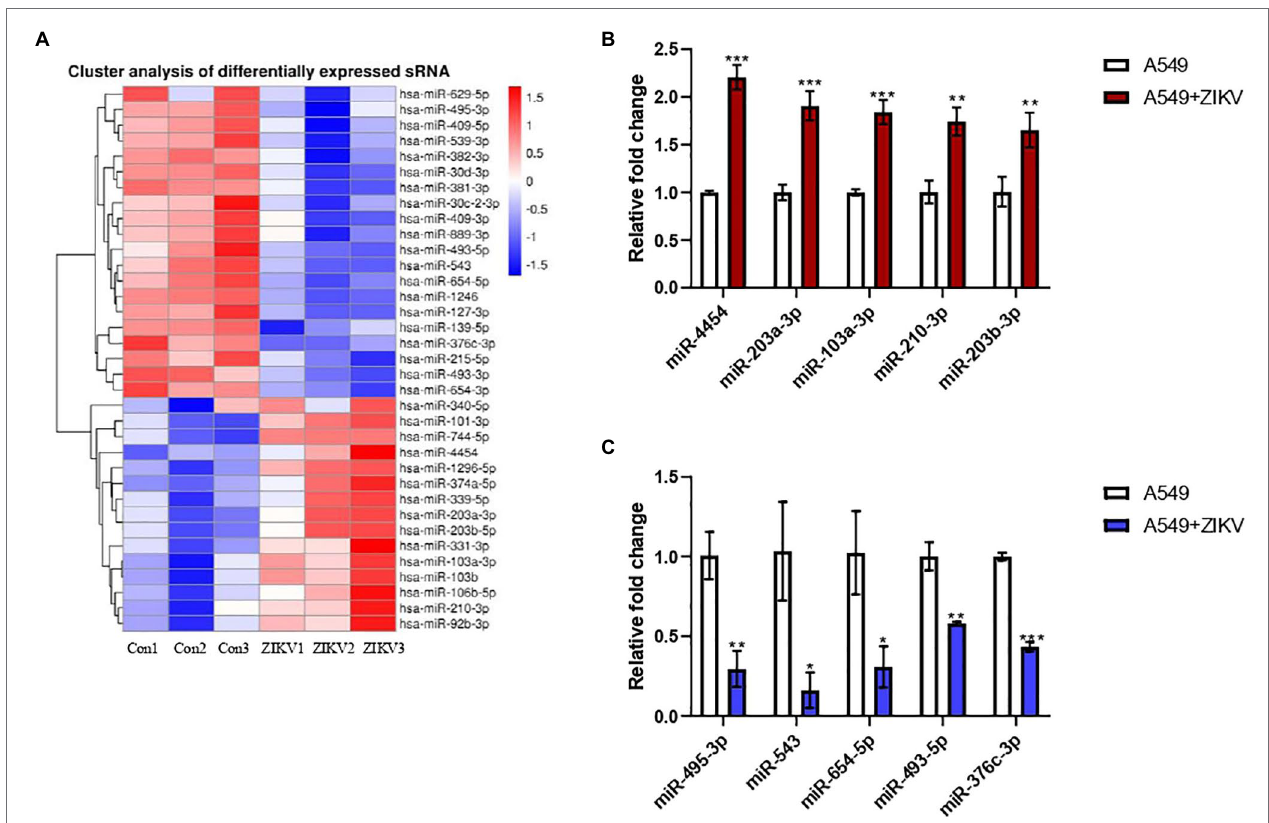
FIGURE 1 | Differentially expressed host MicroRNAs (miRNAs) between A549 and Zika virus (ZIKV) infected A549 cells. A549 cells were infected with ZIKV infection by multiplicity of infection (MOI) of 0.5 and the infected cells were harvested at 48 h post-infection for miRNA profiling by RNA sequencing (RNA-seq) and the data were compared with those obtained from un-infected A549 cells. (A) Heat map analysis of the miRNAs expression. Red indicates upregulation and blue indicates downregulation. (B) Five upregulated candidate miRNAs were selected to verify by qRT-PCR. (C) Five downregulated candidate miRNAs were selected to verify by qRT-PCR. Data are normalized to U6 and presented as mean ± SD. Error bars indicate SD ( n ≥ 3). * p < 0.05, ** p < 0.01, and *** p <